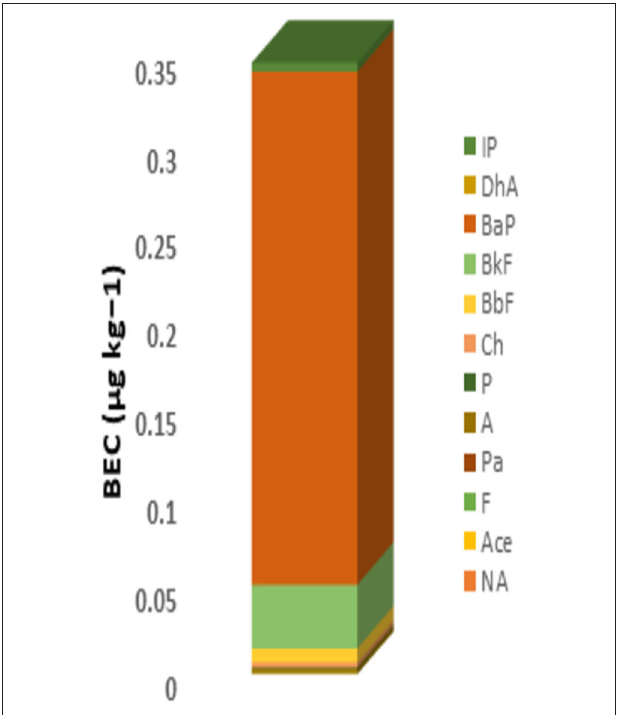
FIGURE 1 | BEC value and contribution due to content of PAHs in baby